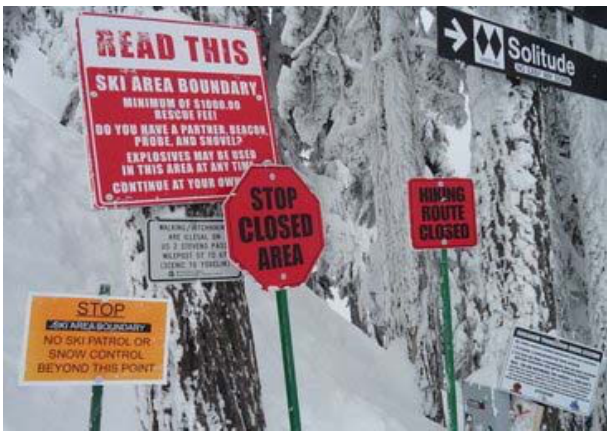
Figure 3. Picture of the warning signs passed by the group of skiers.